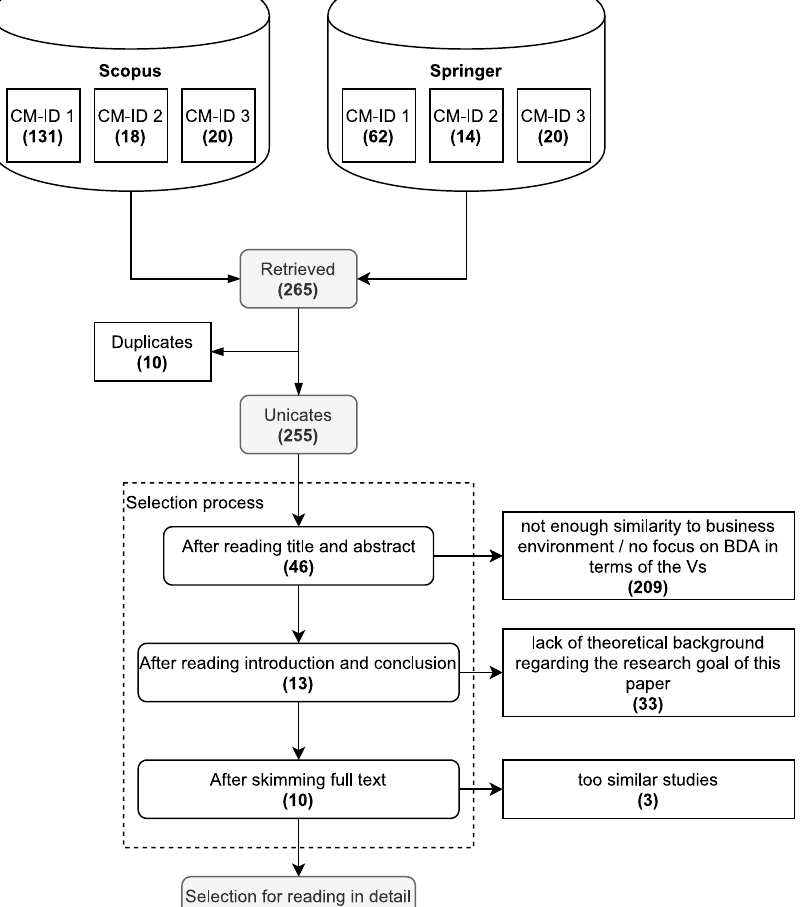
Figure 3. Literature review search